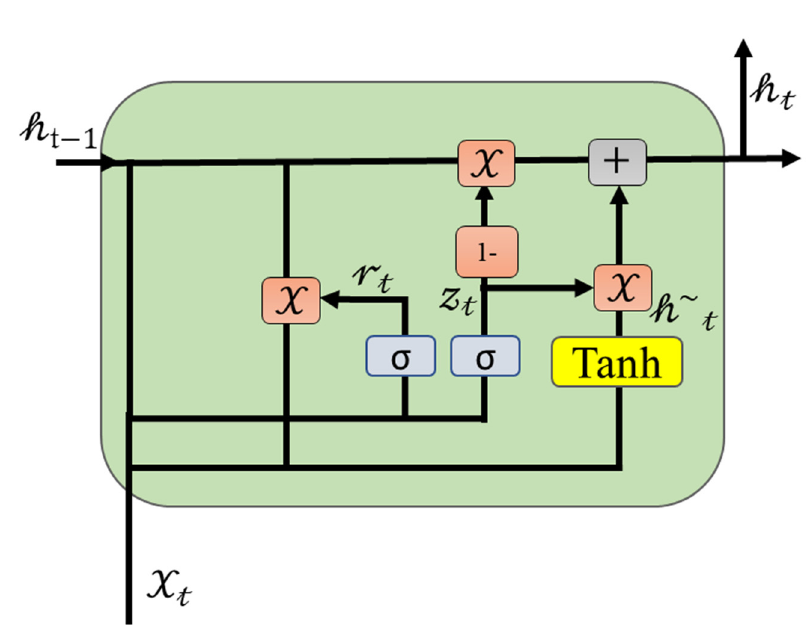
Figure 2. Illustration for the internal mechanism of GRU .